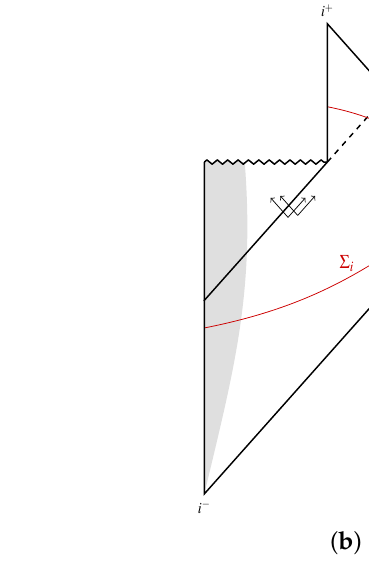
Figure 1. ( a ) Gravitational collapse of a star. While the past boundary of space–time consists only of + and the black hole singularity. There is information loss in , the future boundary is the union of I − I the future evolution because the singularity can soak up part of the information. ( b ) Commonly used Penrose diagram to depict black hole evaporation, including back reaction. Modes are created in pairs, + and its partner falling into the black hole. The dashed line is the continuation of one escaping to I + at retarded time u the event horizon that meets EH . If this were an accurate depiction, the future I singularity would again act a sink of